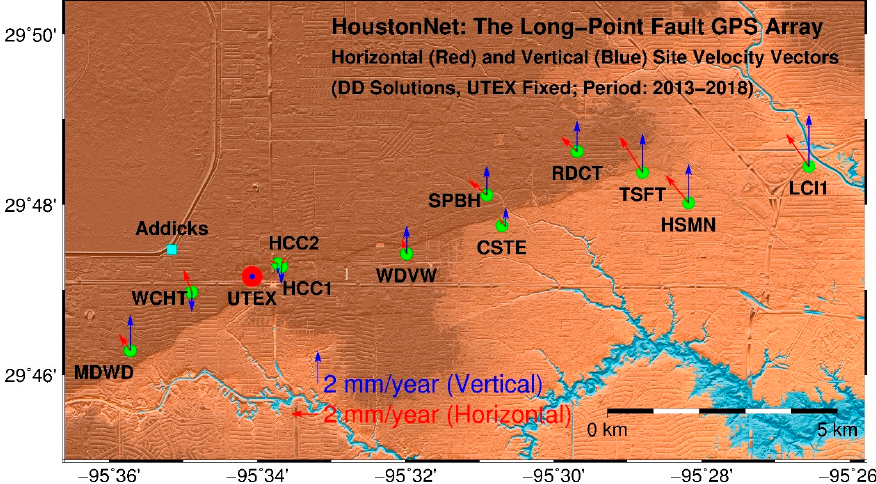
Figure 10. Site velocity vectors (blue: vertical; red: horizontal) of 11 GPS antennas with respect to the antenna of UTEX. The uncertainties (2 σ , 95% confidence level) of the velocities are ±0.1 to ±0.3 mm/year in the horizontal direction, and ±0.2 to ±0.6 mm/year in the vertical direction.